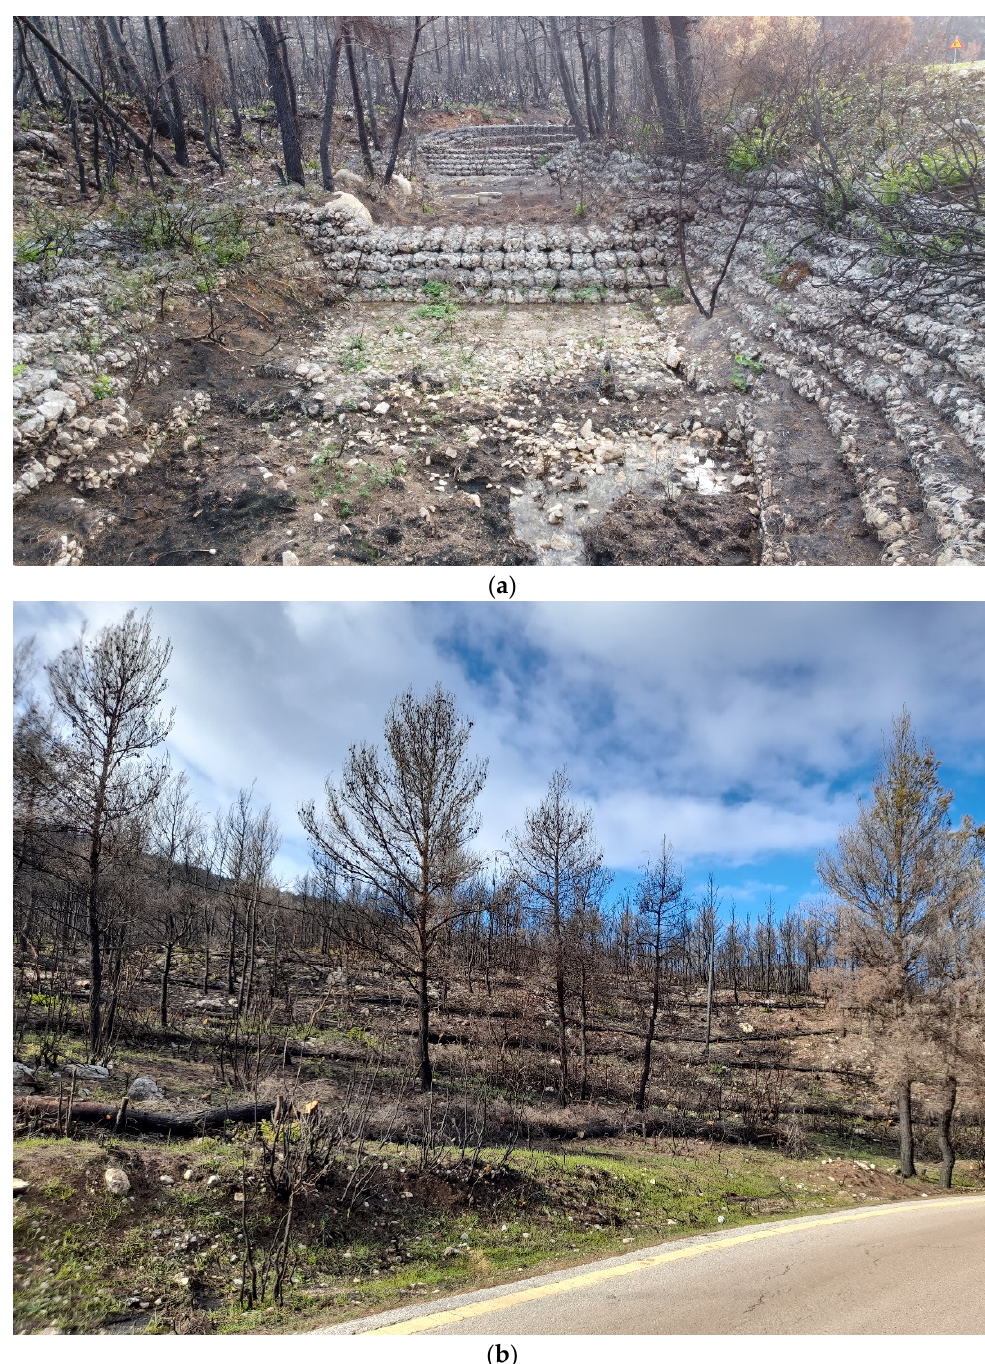
Figure 14. Examples of flash flood protection measures in Attica region (photo credit for b: A. Geramoutsos). Photos taken ( a ): 3 November 2021, ( b ): 16 December 2021.